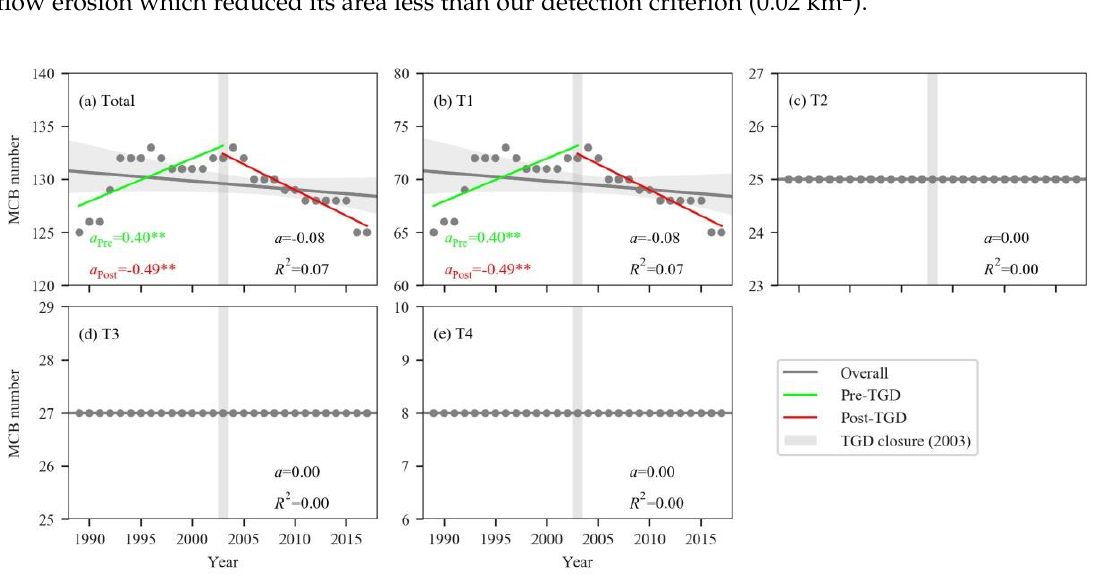
Figure 7. Temporal dynamics of MCB number for different groups of MCBs: ( a ) Total MCBs, ( b ) T1 MCBs, ( c ) T2 MCBs, ( d ) T3 MCBs, and ( e ) T4 MCBs. The regression parameters a and R2 stand for regression slope and coefficient of determination, respectively. Slope value with “*” and “**” indicate the corresponding p -value < 0.05 and < 0.01, respectively.